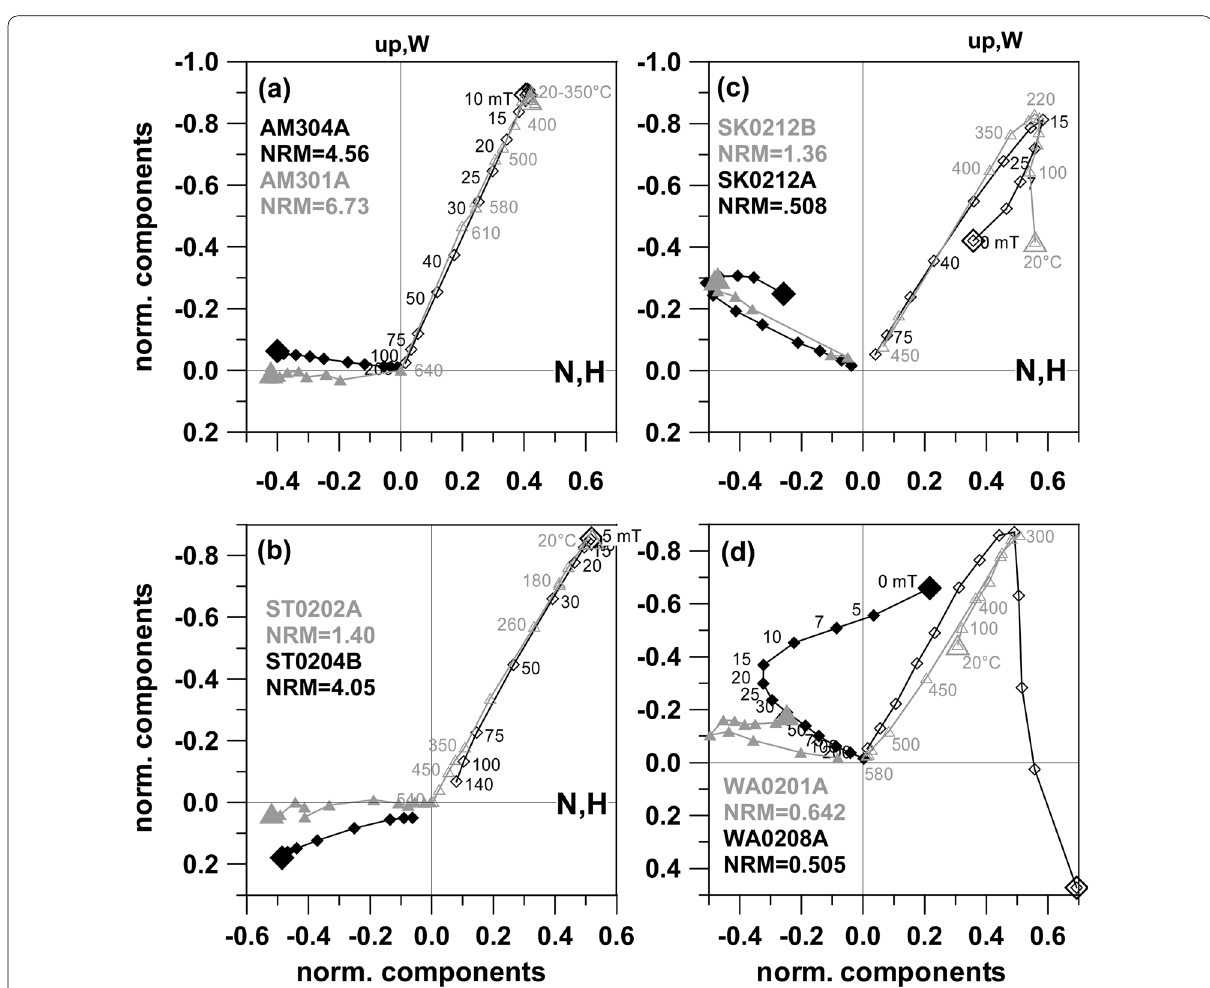
Fig. 4 AF (black) and thermal (gray) demagnetization results from a Altenmarkt, b Stein, c Stradner Kogel and d Waltra sites in orthogonal projections. NRM is indicated by a larger symbol. North component is plotted versus East component (closed symbol) and vertical component versus horizontal component (solid symbol). Numbers give demagnetization steps in mT or °C. Specimen names are indicated and NRM intensity is given in